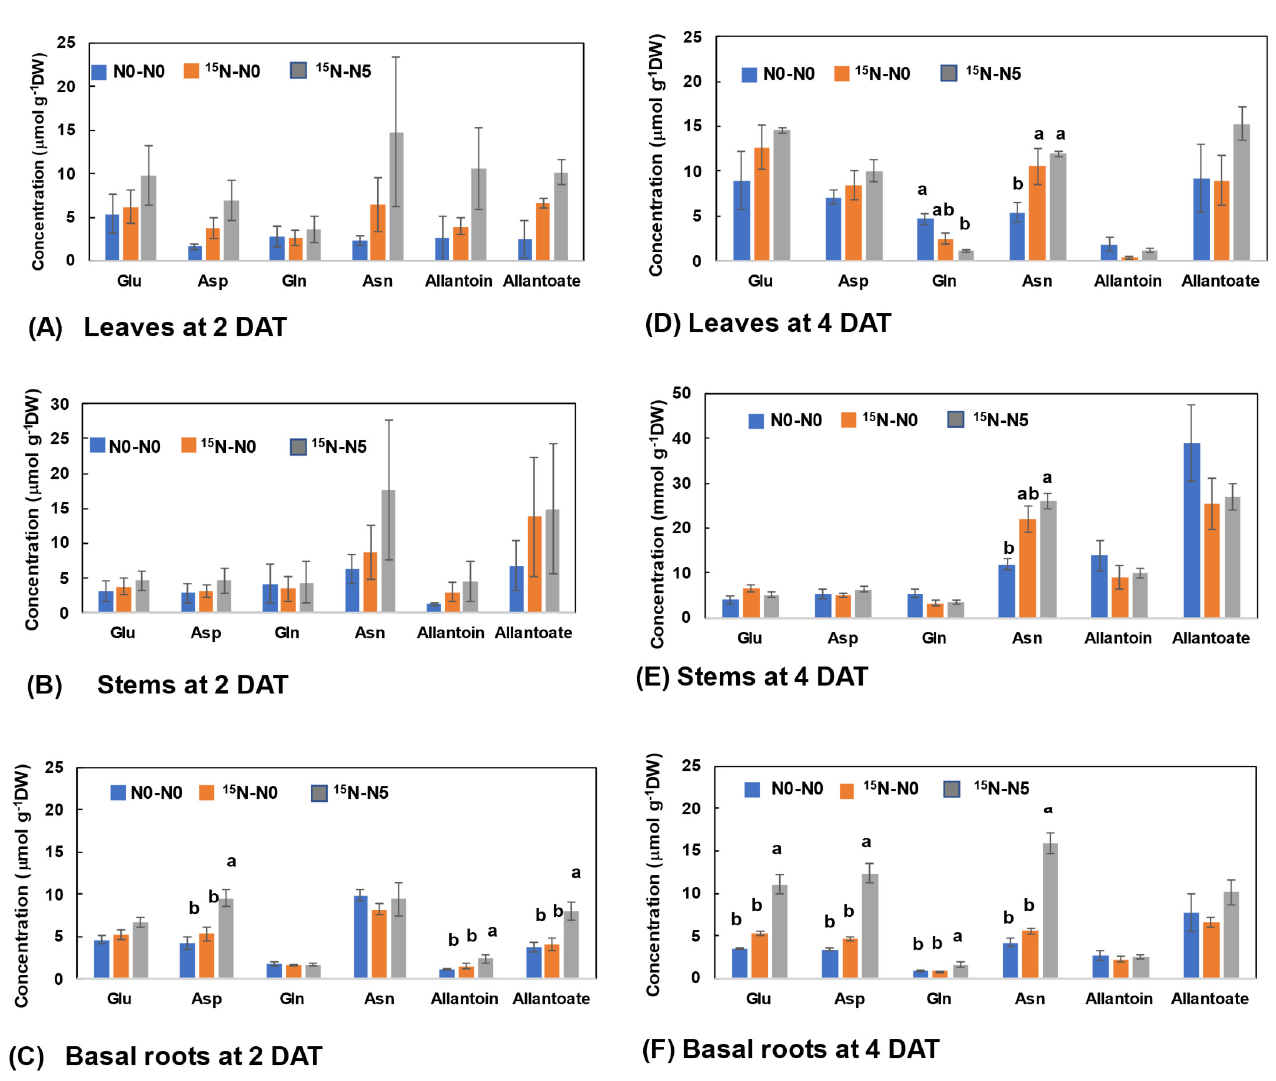
Figure 6. Comparison of the concentrations of principal N metabolites in the leaves, stems, and basal roots of soybean plants with split root experiments with N0-N0, 15 N5-N0, and 15 N5-N5 treatments. ( A ) Leaves at 2 DAT, ( B ) Stems at 2 DAT, ( C ) Basal roots at 2 DAT, ( D ) Leaves at 4 DAT, ( E ) Stems at 4 DAT, ( F ) Basal roots at 4 DAT. The different letters indicate significant differences among treatments based on Tukey’s test ( p < 0.05). Different letters indicate a significant difference ( p < 0.5) based on Tukey’s test. N = (4). Average ± SE.